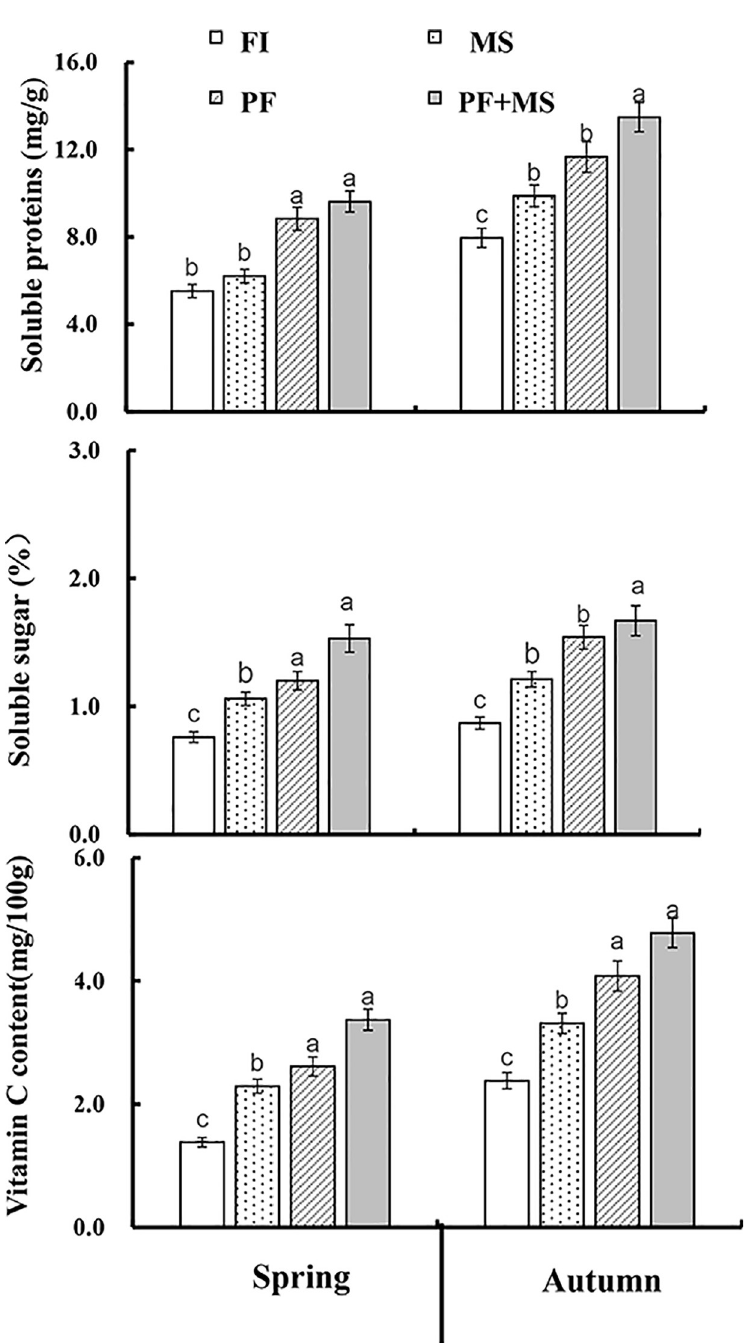
Fig 6. The effects of different irrigation systems on the quality of lettuce including soluble protein, soluble sugar and vitamin C content.